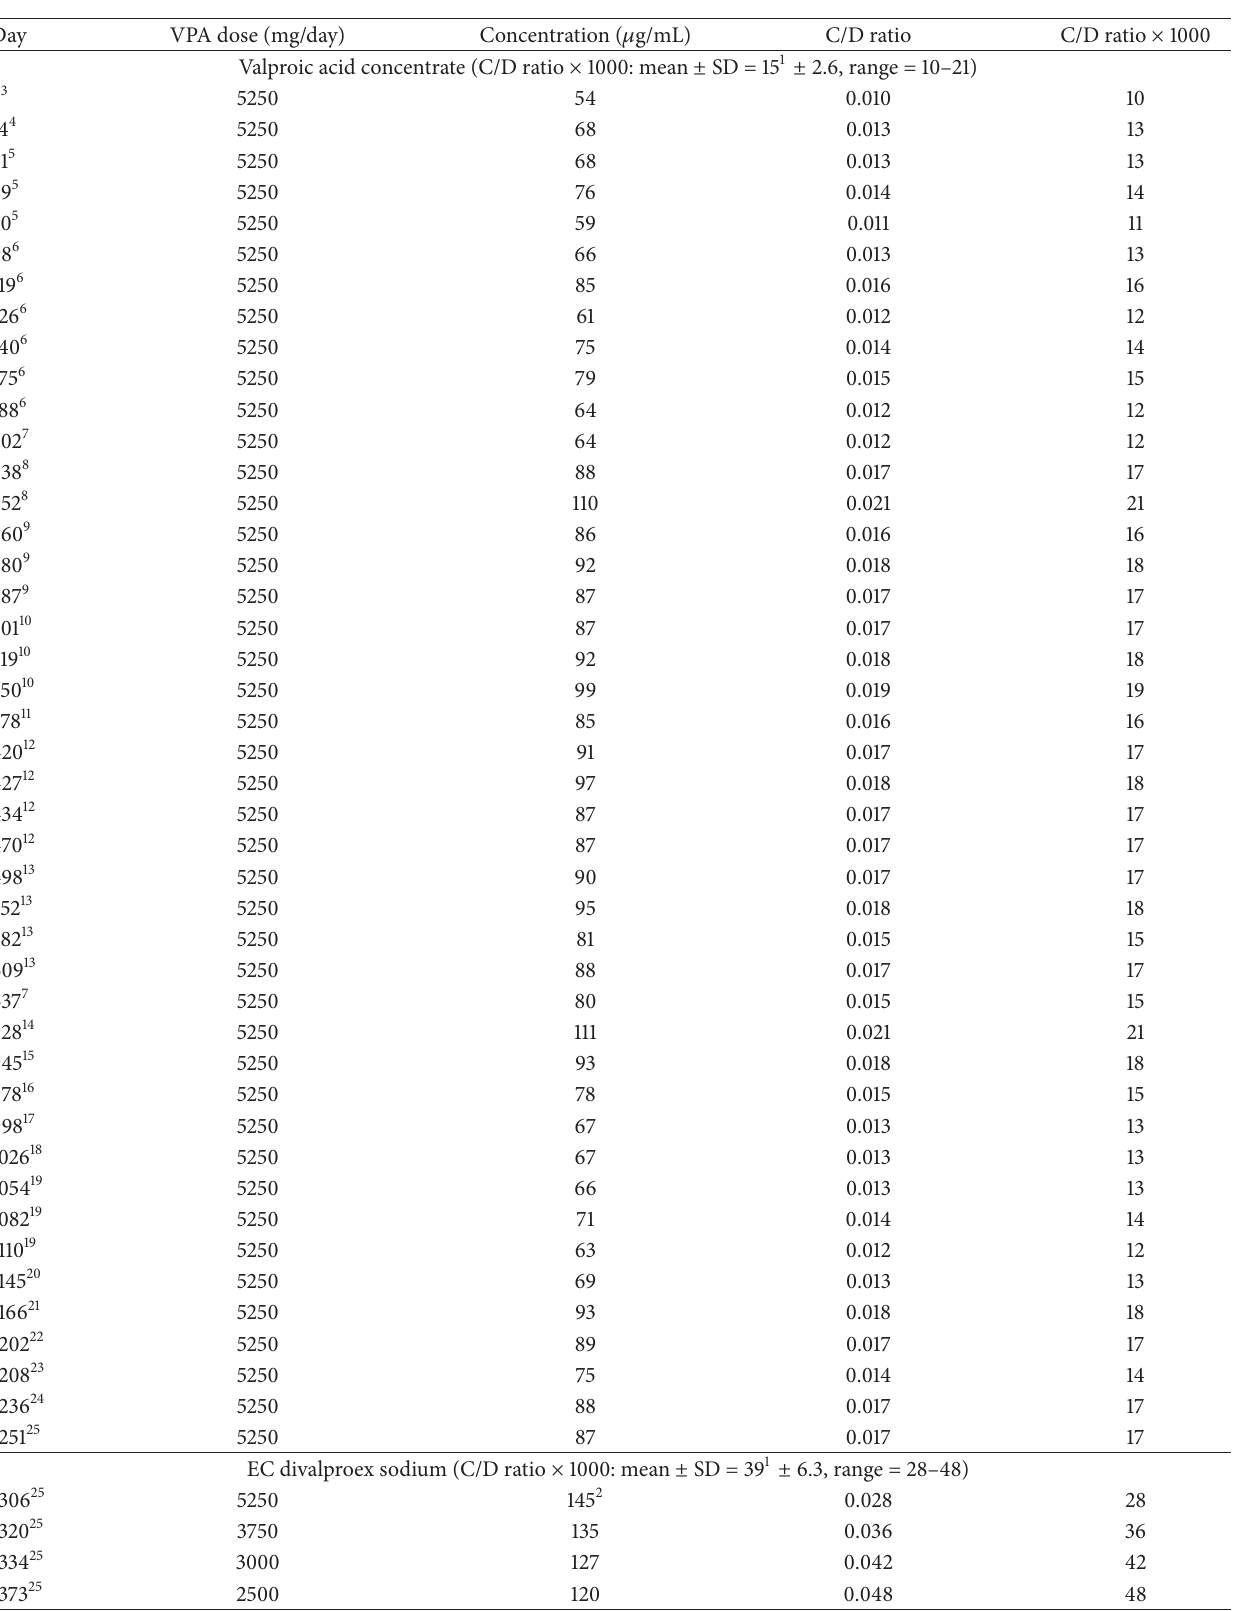
Table 2: VPA C/D ratio in Case